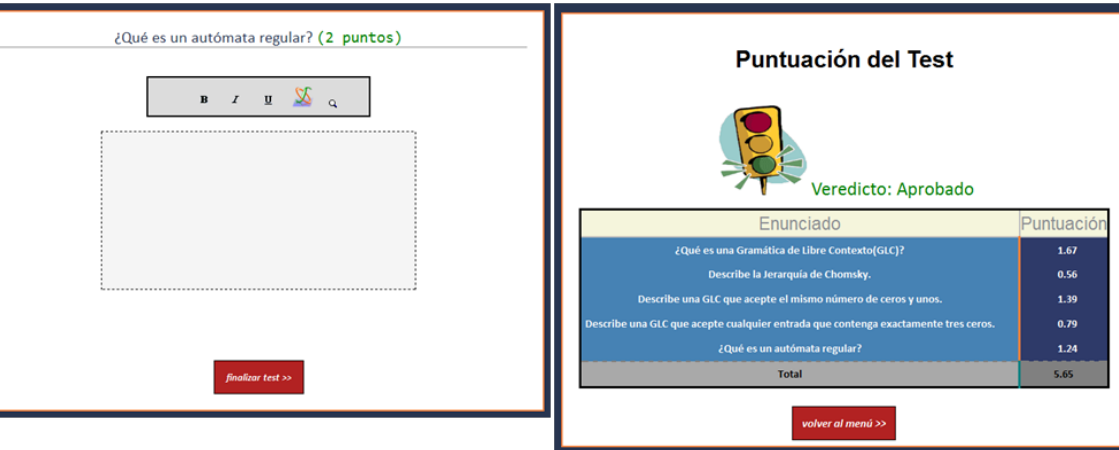
Figure 3 . Question and text editor with MathEdit (a) and mark of the test once it is finished